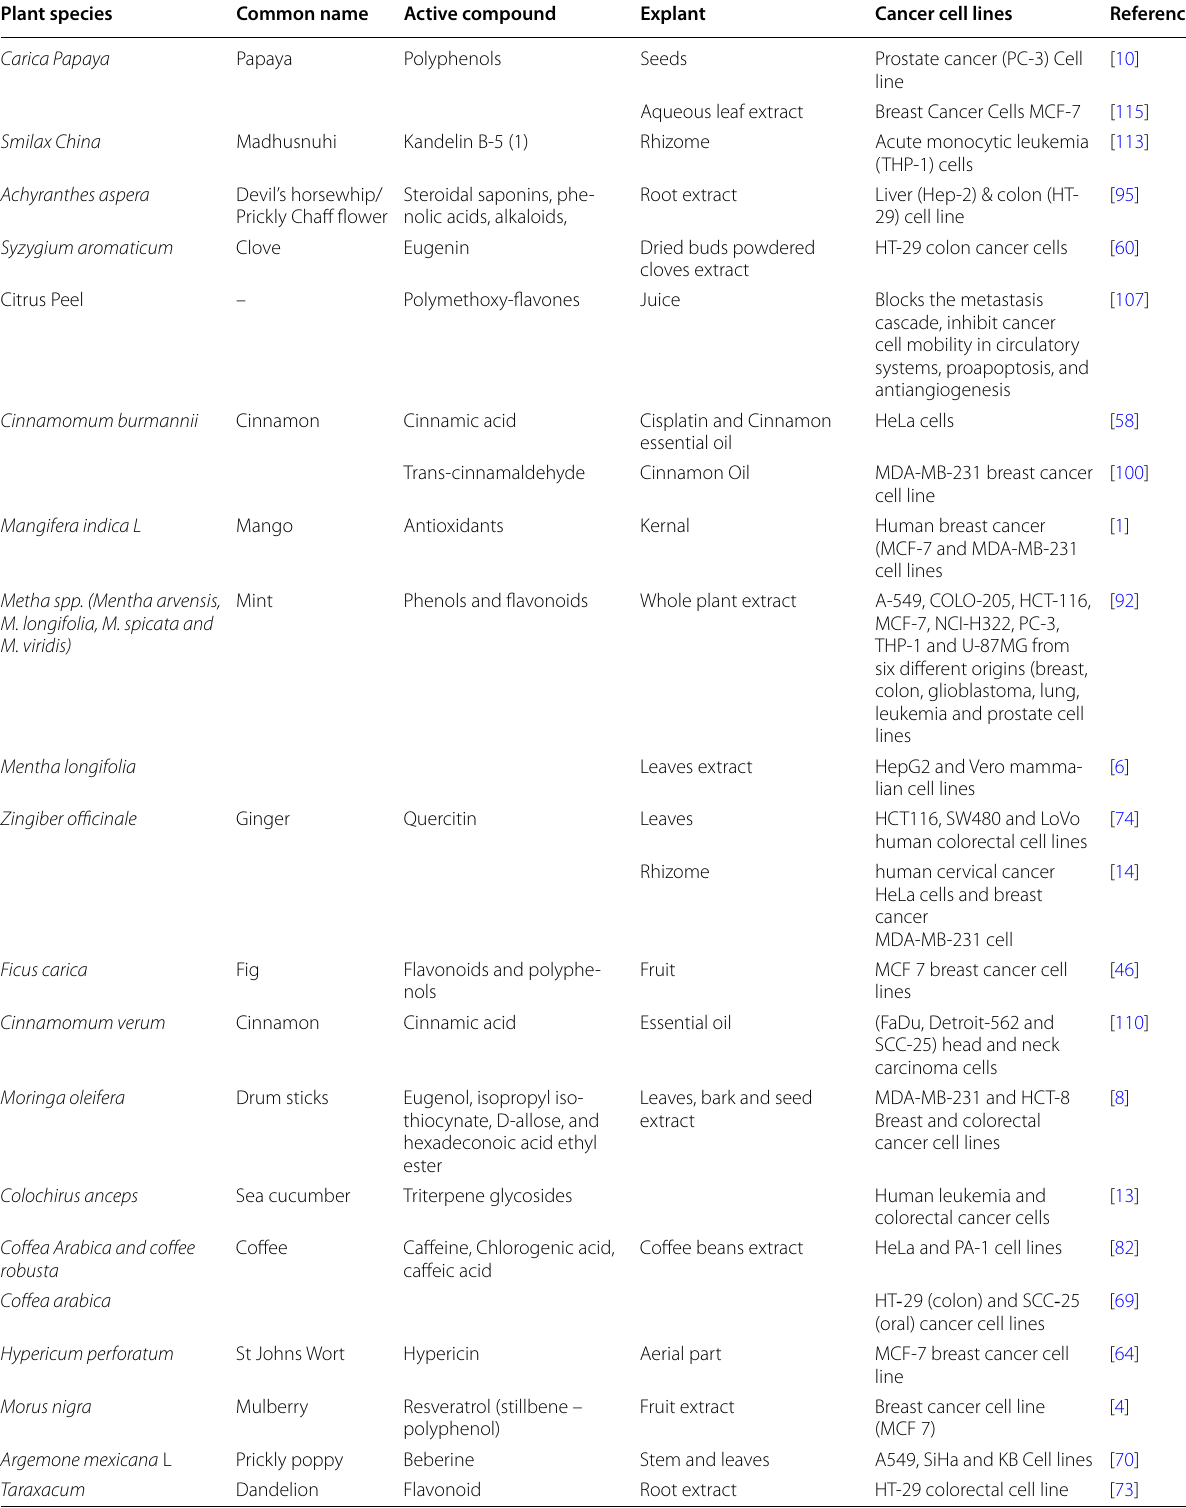
Table 4 Potential bioactive compounds targeted with anticancer properties in plants Plant